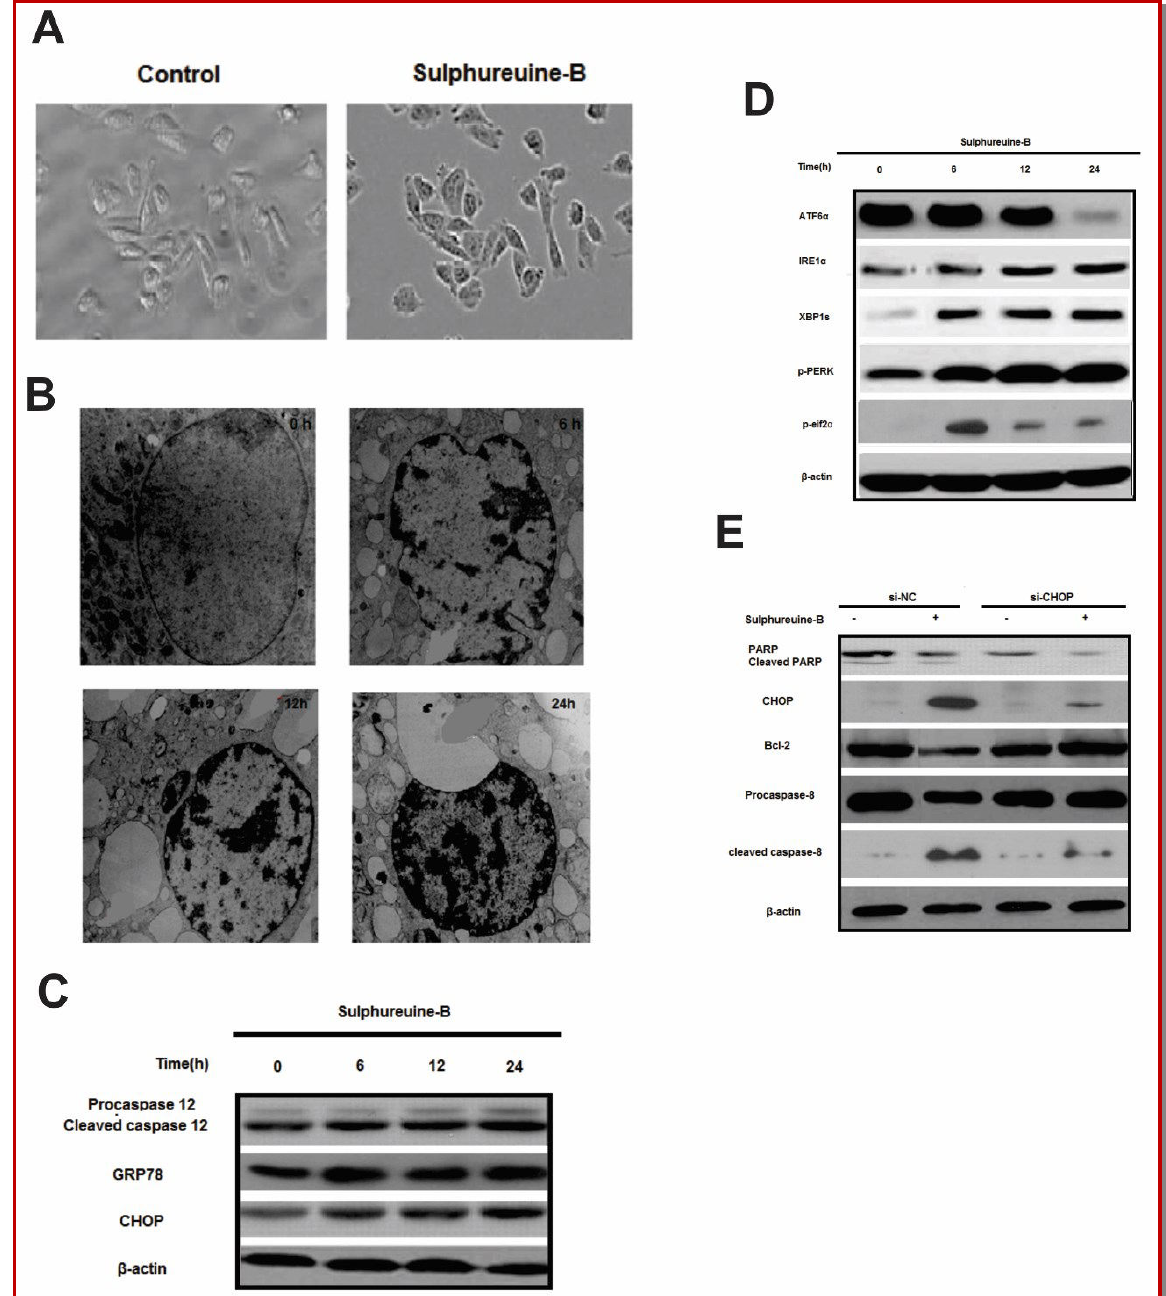
Figure 6: A) Cytoplasmic vacuolation results upon treating U-87MG cells with 20 µM sulphureuine B for 24 hours; B) TEM ultrastructure results upon treating U-87MG cells with 20 µM sulphureuine B for 0, 6, 12 and 24 hours; C) Western blot results upon treating U-87MG cells with 20 µM sulphureuine B to detect GRP78, CHOP, and caspase-12 for 0, 6, 12 and 24 hours; D) Immunoblotting results upon treating U-87MG cells with 20 µM sulphureuine B to detect p-PERK, ATF6 α, pEIF2 α, IRE1 α and XBP1s, Fas & FADD using β - actin as control; E) si-RNA transfection results upon transfecting U-87MG cells with si-RNA as negative control or with CHOP si-RNA and lysed after treated with 20 µM sulphureuine B to detect the CHOP, caspase 8, PARP, Bcl-2 expression levels using western blot analysis. β - actin was used as